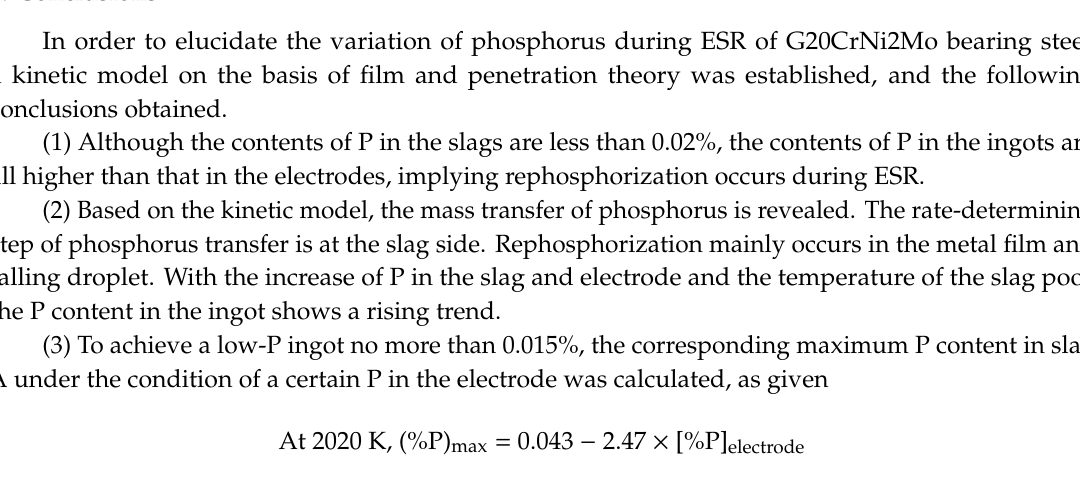
Figure 12. Mechanism of rephosphorization during the electroslag remelting (ESR) process.